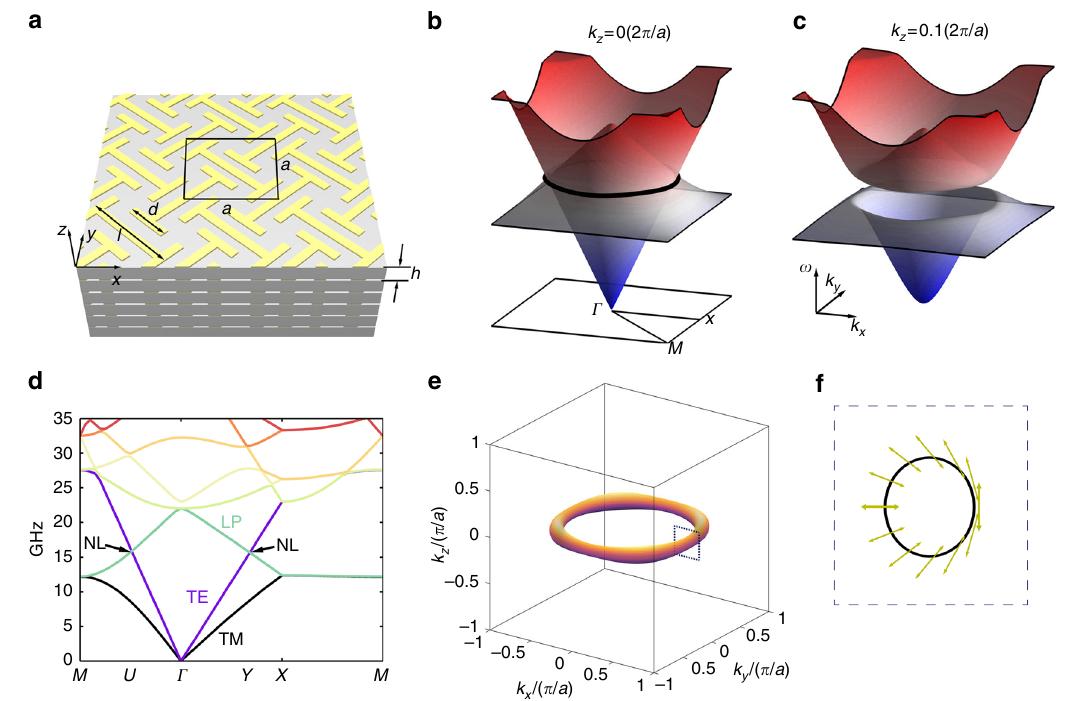
Fig. 1 A single nodal line realized in cut-wire metacrystals. a Schematic of the metacrystal. The unit cell size is a = 4.5 mm, h = 2 mm. The size of the I- shaped copper cut-wire resonators is l = 1.1a, d = 0.5a. The widths of all wires are 0.1a, and the thicknesses are 35 μ m. The substrate material is Te fl on, whose permittivity is 2.1, with a loss tangent around 0.00028. The band structure of the metacrystal at zero and non zero k z are given in b and c , respectively. d Band structure of the metacrystal at high symmetry lines. Nodal line (NL) is formed between the second and third band at 16 GHz at crystal momentum U and Y . e The equi-frequency surface of the metacrystal exhibits a torus shape at 16.325 GHz, which is slightly above the NL frequency around 16 GHz. No other states are present in the Brillouin zone. f Polarization states on the NL calculated by an effective medium analysis. The area surrounded by the dashed line corresponds to the same area in e . Berry phase of the NL is well manifested by the nontrivial winding of polarization